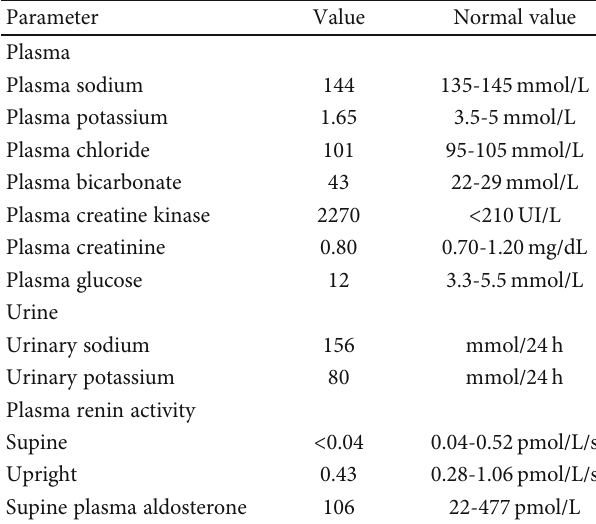
Table 1: Pertinent laboratory fi